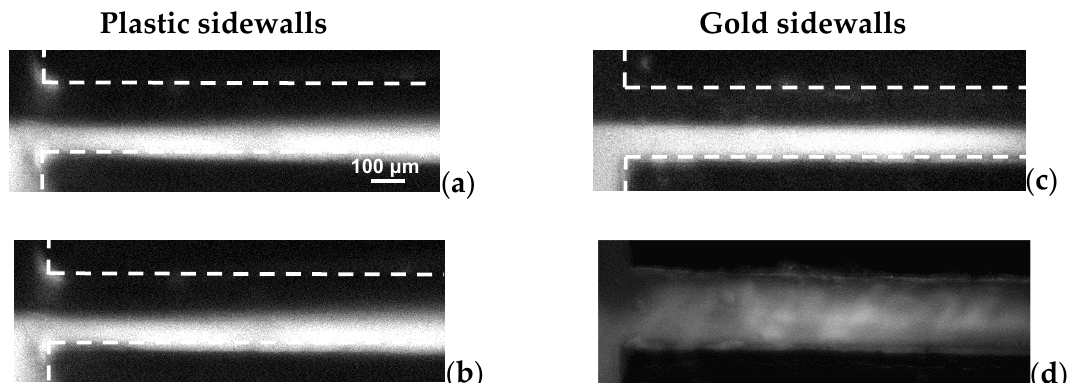
Figure 3. Comparison of mixing results under different electrode positions and corresponding electric fields. In ( a , b ), electrodes are located at the ends of the channel (plastic sidewalls) and the electric field is orthogonal to the initial conductivity gradient between the two streams. In ( c , d ) electrodes (gold sidewalls) are placed at the sidewalls and the electric field is in transverse direction and in parallel to the initial conductivity gradient between the two streams.